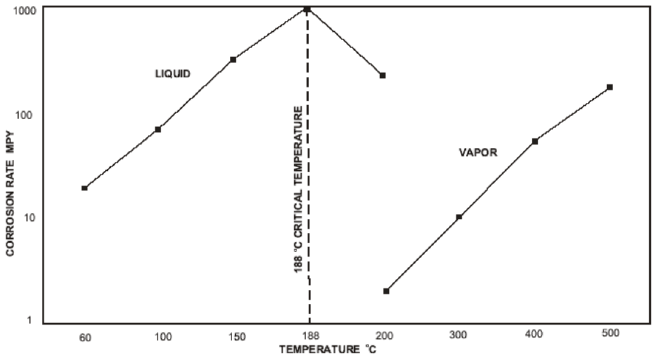
Figure 7. Curve of the corrosion rate of carbon steel as a function of temperature when immersed in static anhydrous HF for 100 h.